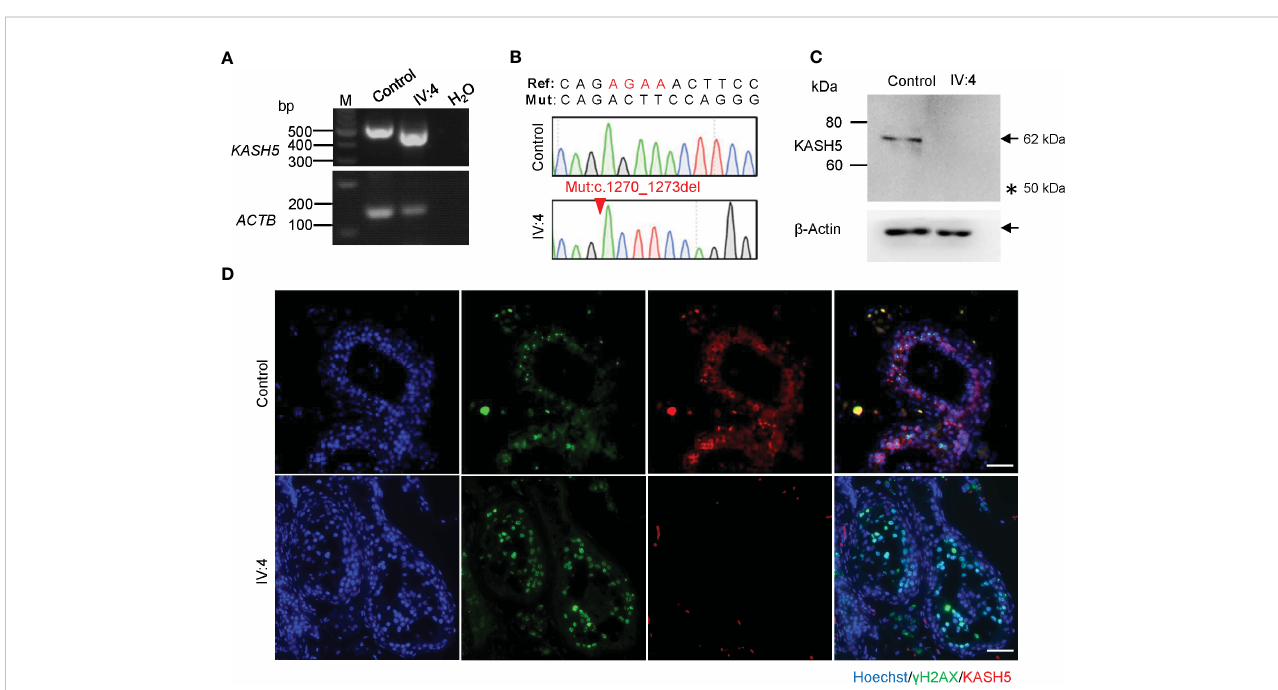
FIGURE 2 Absence of KASH5 proteins and meiotic arrest prior to pachytene stage in the male patient. (A) RT-PCR analysis of testicular samples from a man with obstructive azoospermia (serving as the control) and IV:4. ACTB served as the loading control. (B) Sequencing chromatograms of testicular cDNAs from the patient and control. The red arrow indicates the KASH5 mutation (c.1270_1273del). (C) Analysis of the expression of KASH5 in the testicular sample of IV:4 by western blotting. b -Actin served as a loading control. Arrows indicate the bands corresponding the protein of interest and the asterisk indicates the position of the predicted truncated protein. (D) Immuno fl uorescence staining of testicular sections for KASH5 (red) and g H2AX (green). The nuclei were stained with Hoechst 33342 (blue). Scale bars, 50 µm.